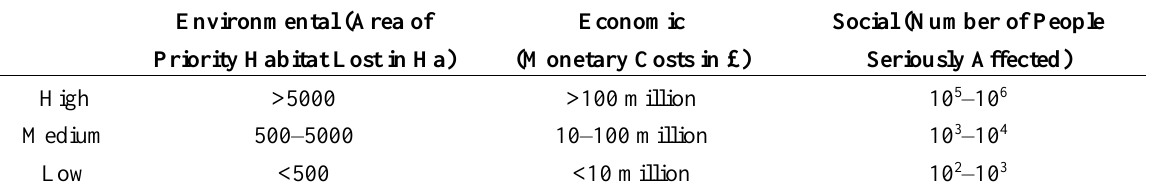
Table 1. Standard Climate Change Risk Assessment (CCRA) reference schema to define level of consequences across